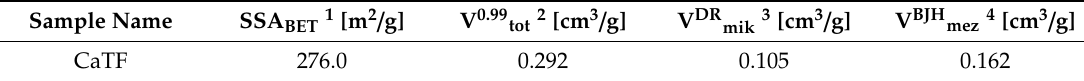
Table 6. Porous texture of a modified reactive material sample